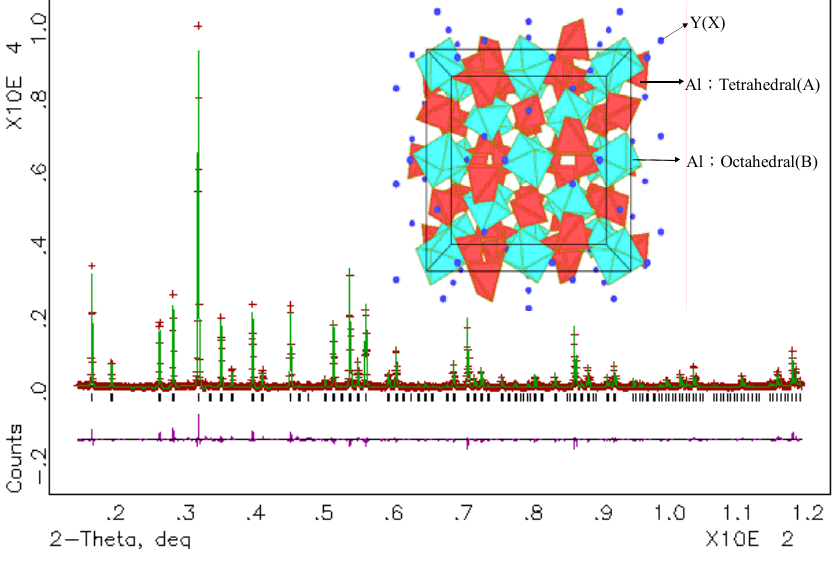
Ce )Al O . Inset presents its three-dimensional 2.93 0.07 5 12